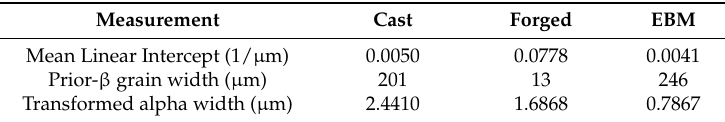
Table 1. Microstructural measurements of Ti-6Al-4V